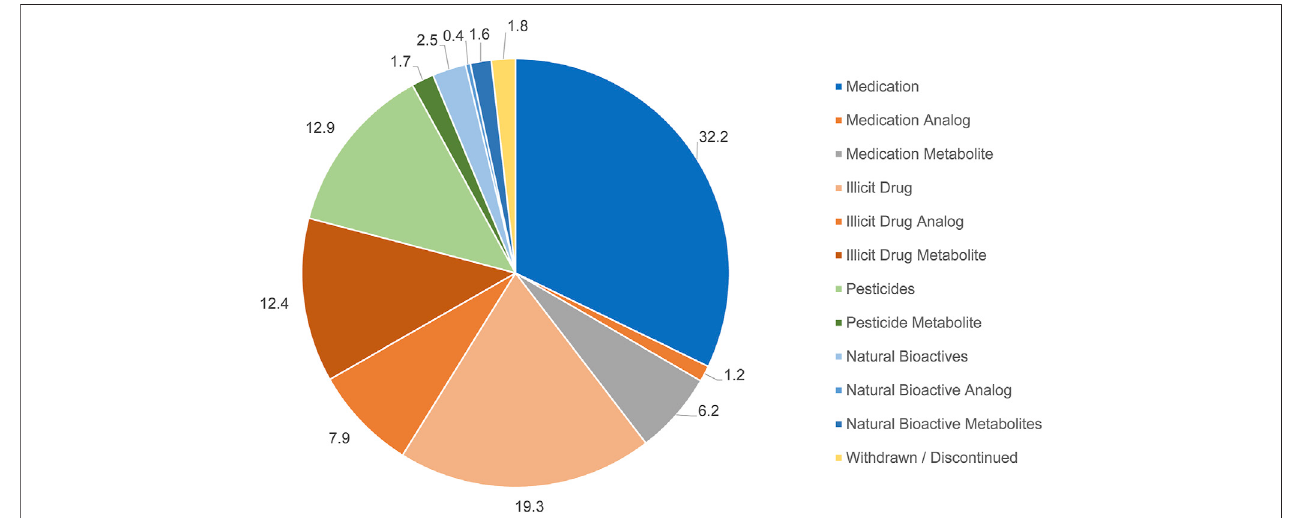
FIGURE 1 | An overall depiction of the chemicals identi fi ed in the 21 wastewater samples and their respective categories. Numbers represent percentage of identi fi ed chemicals that are assigned to that respective category.